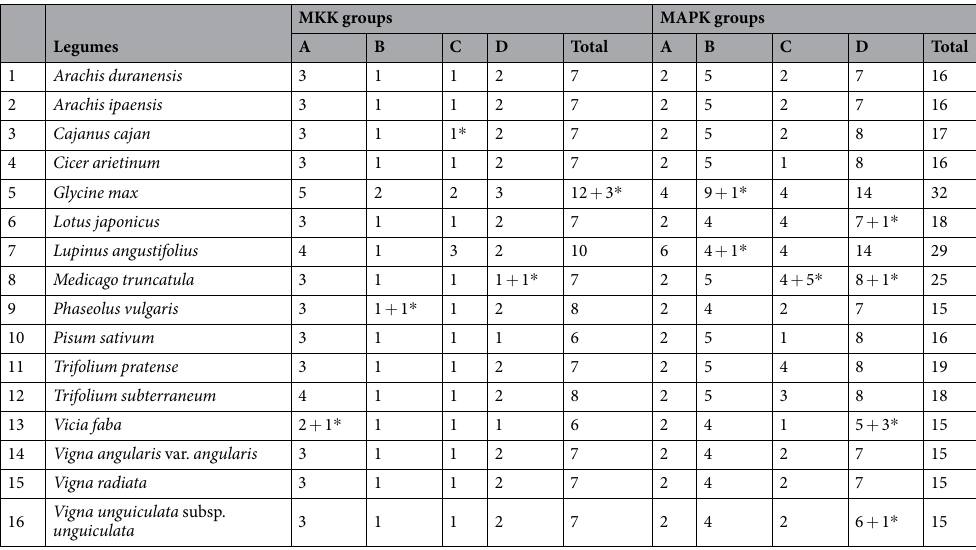
Table 1. Number of MKK and MAPK members identified in 16 legume species. The partial sequences are marked with asterisk ( * ). A full-list of gene/protein identifier along with edited protein sequences is available online in Supplementary Table